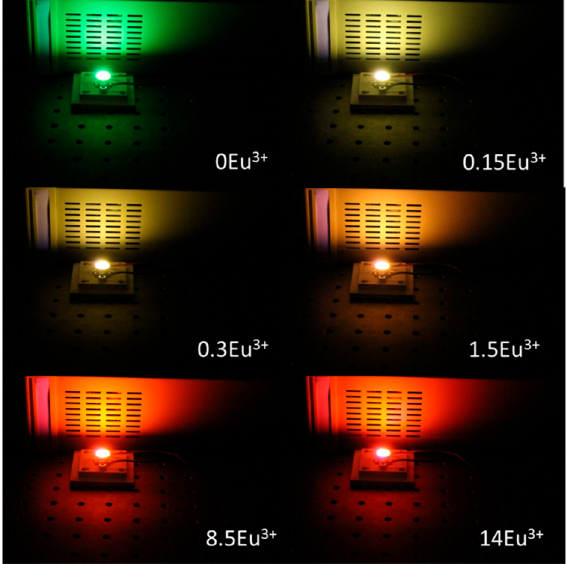
Figure 9. Luminescence photographs of fabricated devices under a 380 nm UV LED chip.